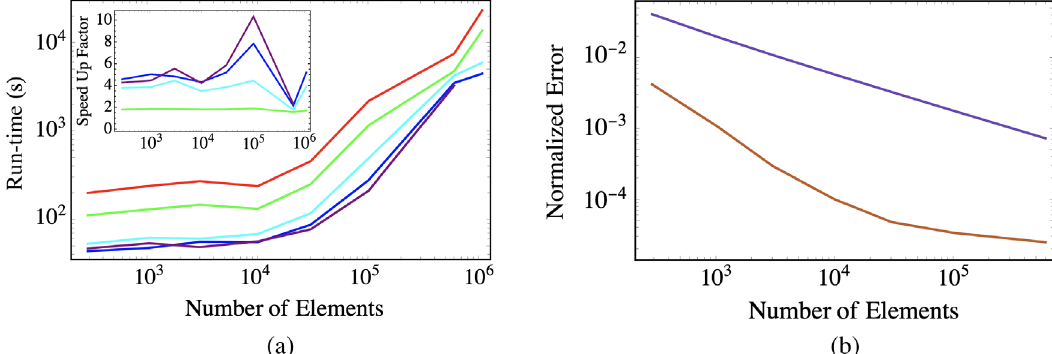
FIG. 5. The left plot shows the computation time for PISCS in serial (red line) and parallel operation with two (green line), six (cyan line), 18 (blue line), and 36 (violet line) processors. The inset shows the speedup factor relative to serial performance. The right plot relates the normalized error in the electric potentials (purple line) and fields (orange line) as a function of the number of boundary elements for the